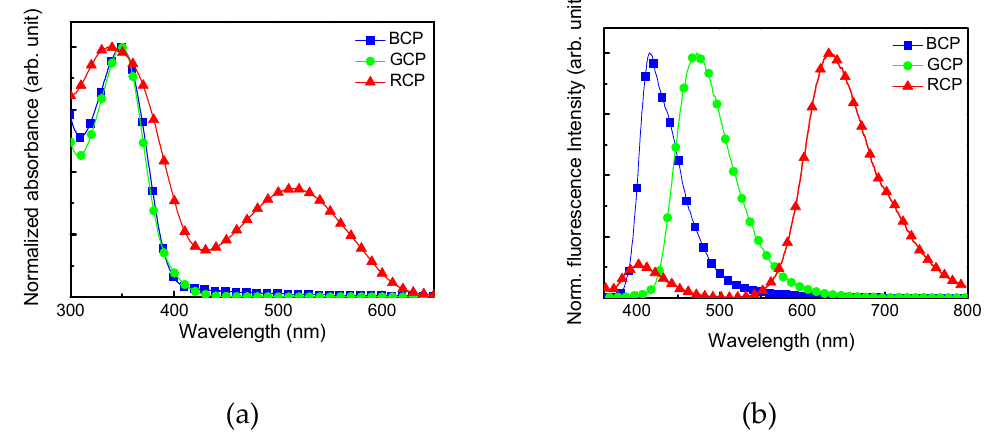
Figure 1. ( a ) UV-vis and ( b ) fluorescence spectra of CP films.